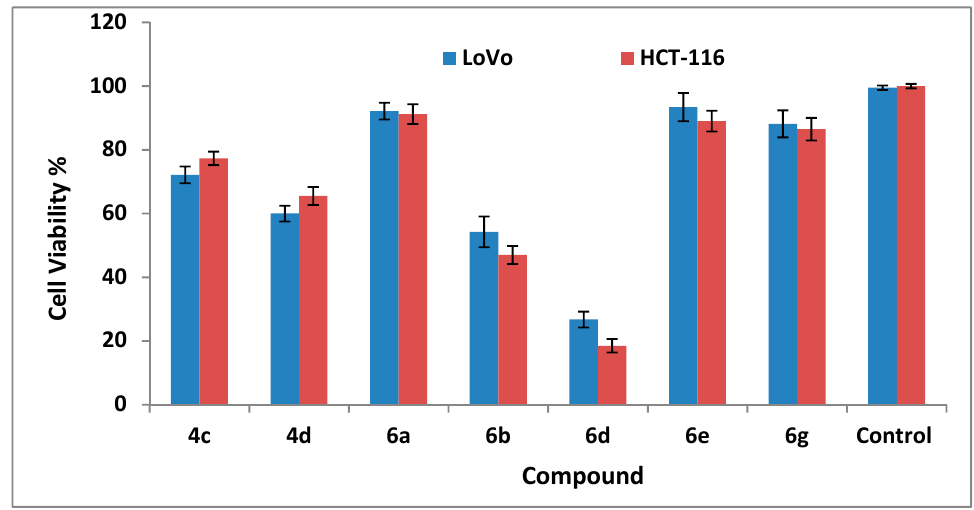
Figure 4. Cytotoxic effects of some selected bioactive Schiff’s bases on LoVo and HCT-116 colorectal cells.